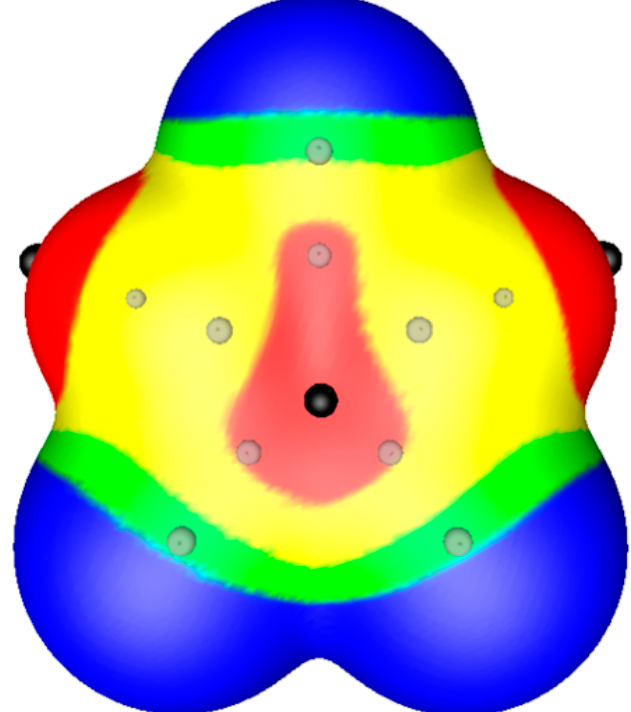
Figure 7. Computed electrostatic potential on 0.001 au molecular surface of parabanic acid, 4 , which is planar. The oxygens are at top and bottom left and right. Gray circles indicate positions of nuclei. Black hemispheres correspond to V S,max due to π -holes above and below approximate center of ring and σ -holes on hydrogens on extensions of C–H bonds. Color ranges, in kcal/mol: red, more positive than 24; yellow, between 24 and 12; green, between 12 and 0; blue, negative.